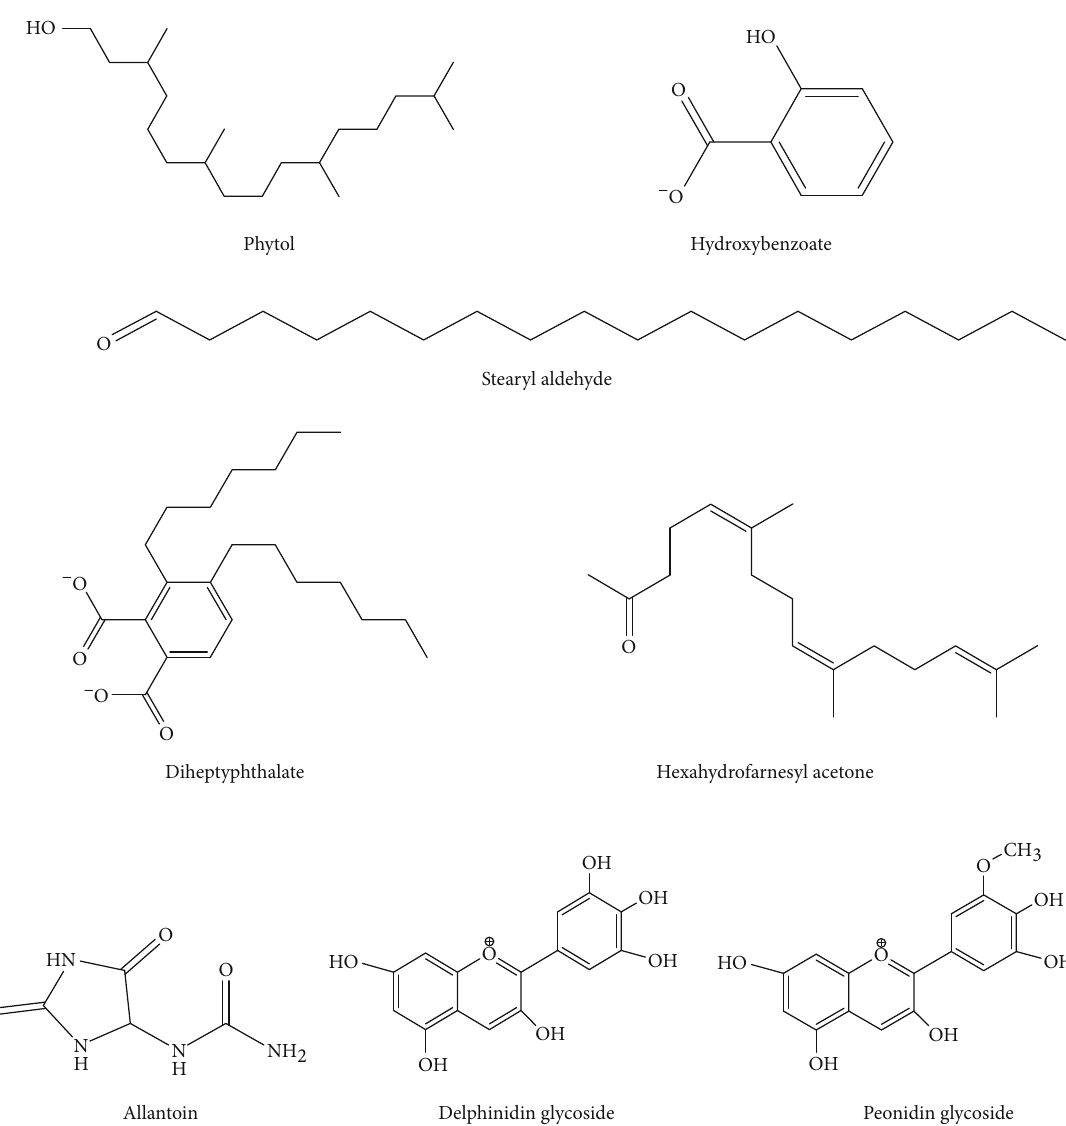
Figure 11: Some other bioactive compounds from P. lanceolata